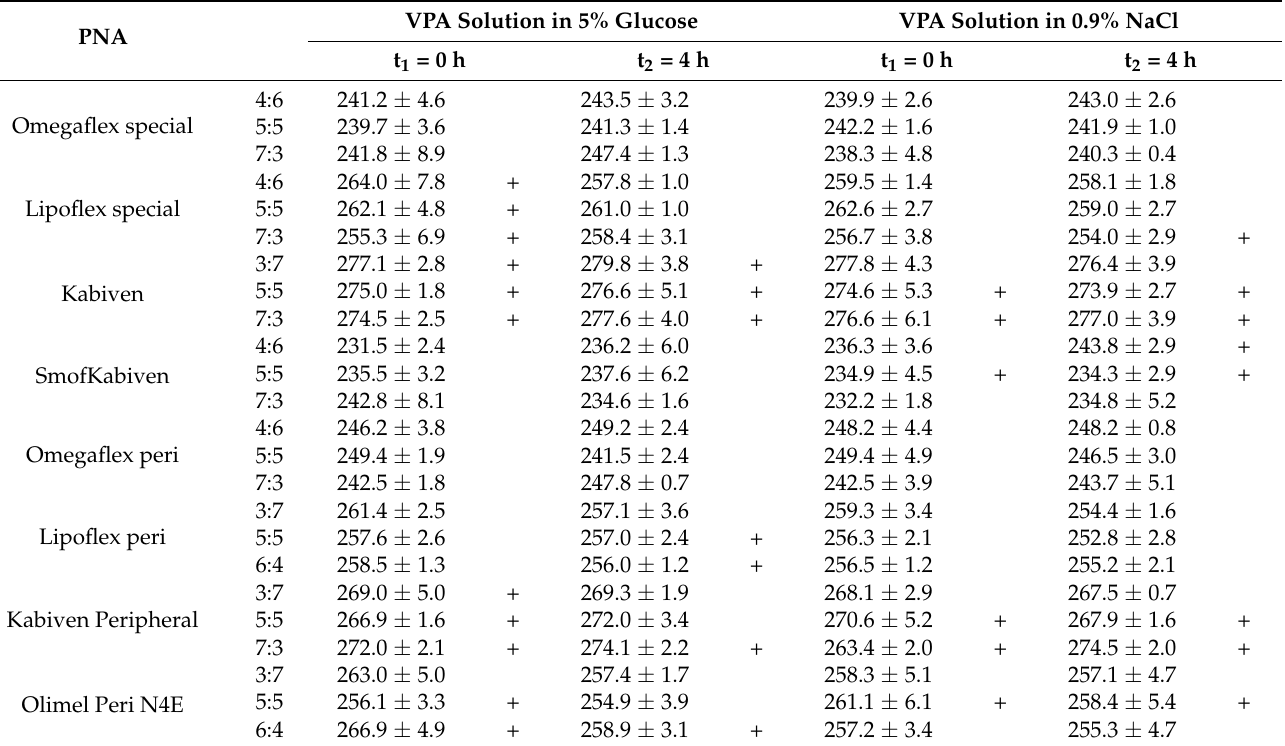
Table 4. The size of lipid droplet (MDD ± SD) in comparison to occurrence of the second fraction of lipid